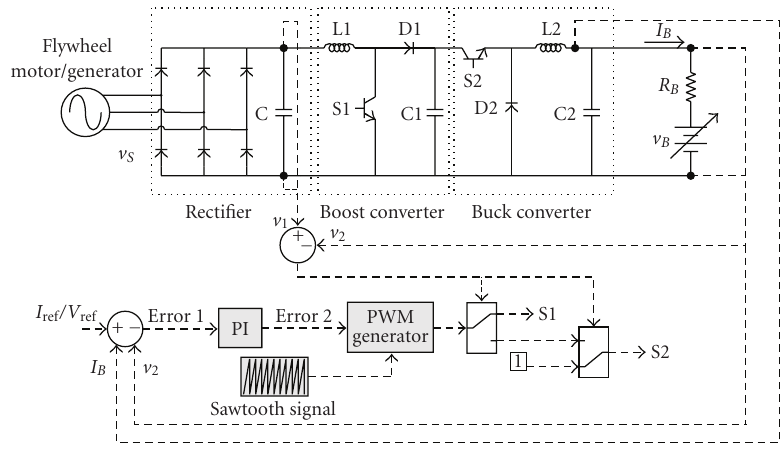
Figure 2: Equivalent circuit diagram of the simulated system.